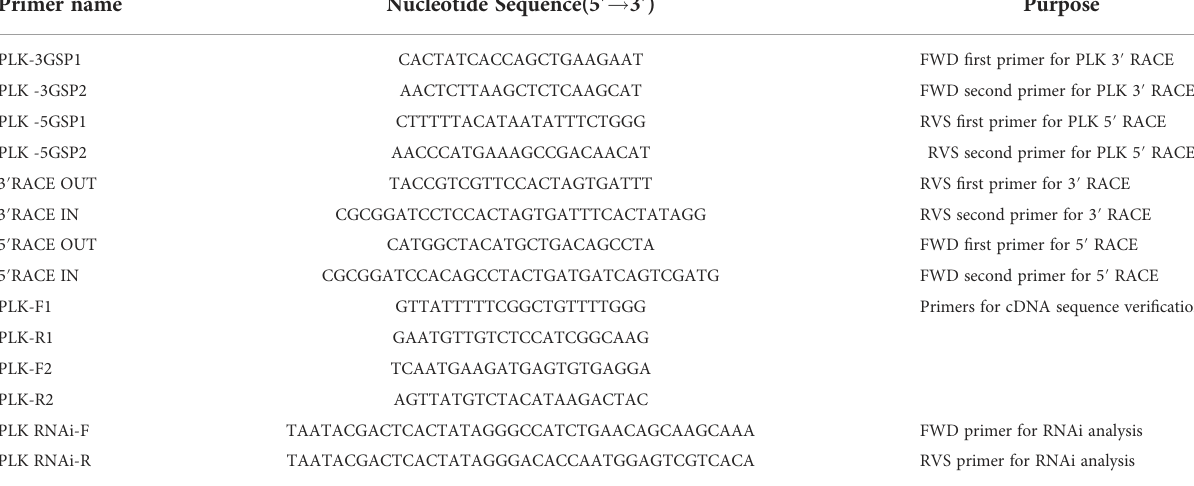
TABLE 1 Universal and speci fi c primers used in this